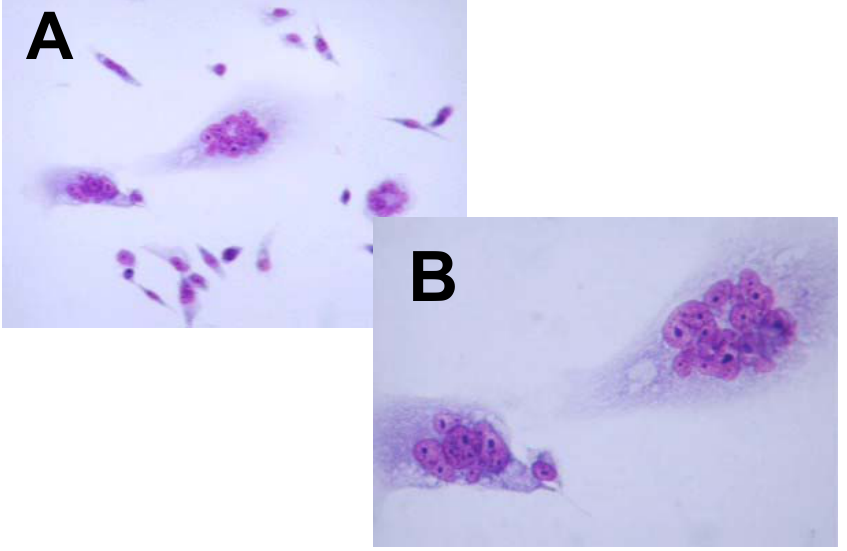
Fig. 4 Specific effects of HSV-2 on TV cells (HE staining: (A) HE × 200, (B) HE × 400). isolation and growth of different viruses. TV cell line was susceptible to the majority of tested viruses: herpes virus, echovirus type 30, measles virus, poliovirus, Coxsackie virus, and